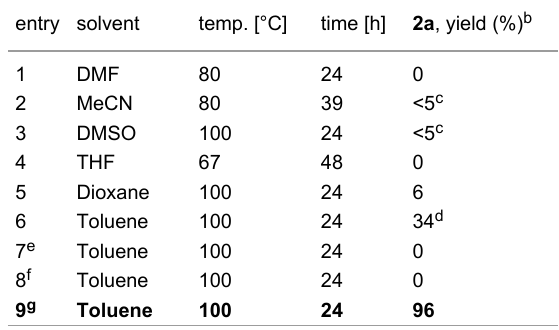
Table 1: Screening of solvents for the CuI-catalyzed reaction of potas- sium thioacetate ( 1 ) with iodobenzene. a